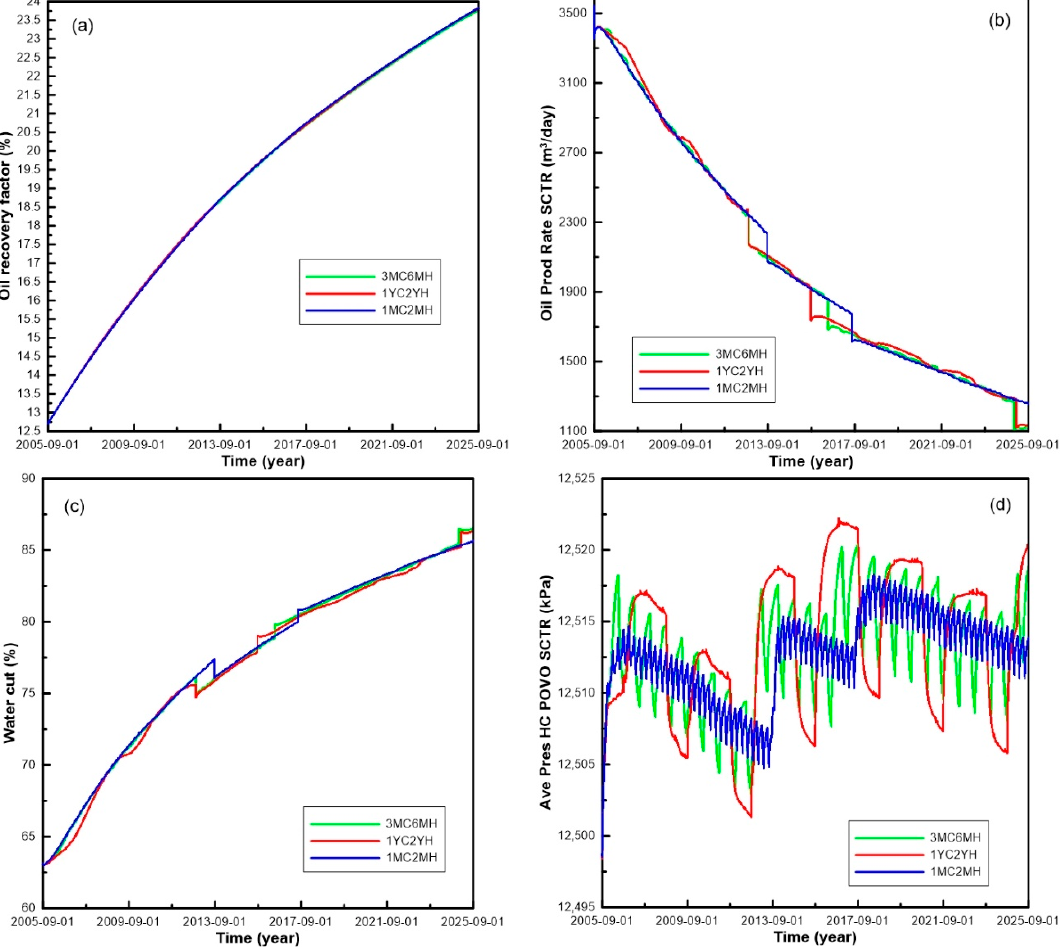
Figure 8. Simulated result curves of oil recovery factor ( a ), oil production rate ( b ), water cut ( c ) and average reservoir pressure ( d ) of during the CO 2 flooding with a WAG ratio of 1:2.